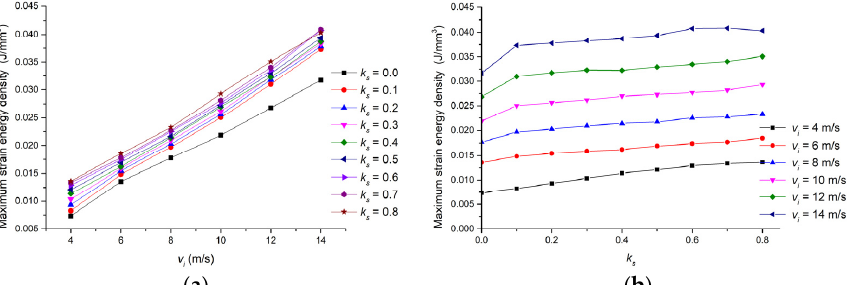
Figure 5. The curves of strain energy per unit volume vs k s for coal specimens subjected to different pre-stress levels and impact speeds.